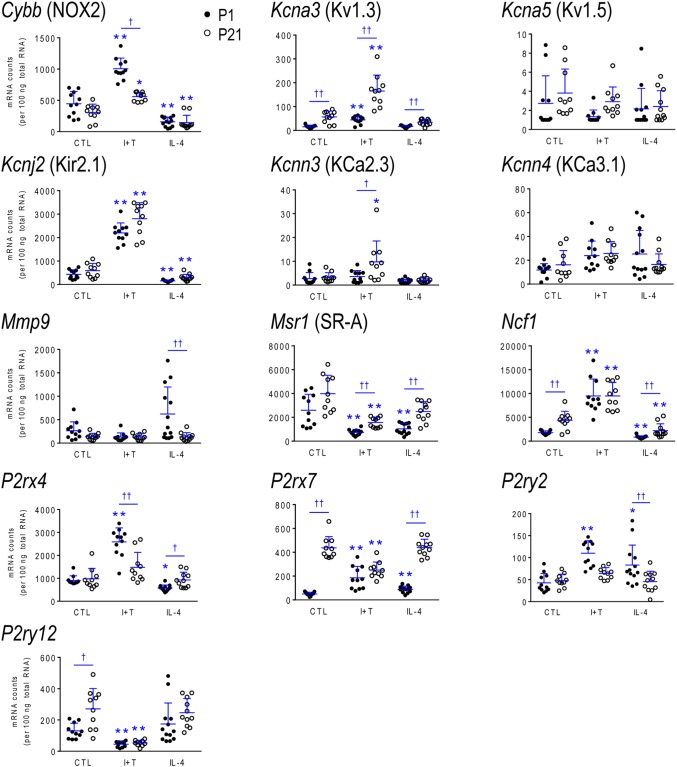
Age-dependent transcriptional responses: Molecules related to selected physiological functions. As in Figure 2, microglia were stimulated for 24 h with IFNγ and TNFα (I+T) or IL-4. The scatterplots show individual mRNA values (normalized; see Materials and Methods) and the mean ± SD. Differences shown are with respect to control microglia (∗) and between P1 and P21 cells (†). One symbol of either type indicates p < 0.05; two symbols, p < 0.01.